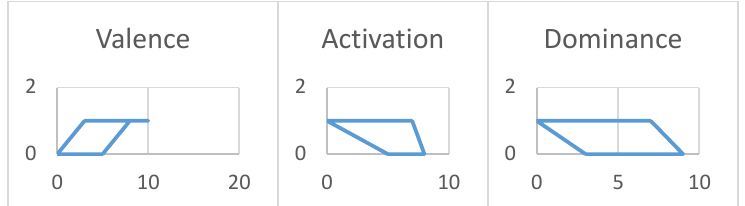
Fig. 16. The FOU of Ihunaya (Love) for dimensions valence, activation and